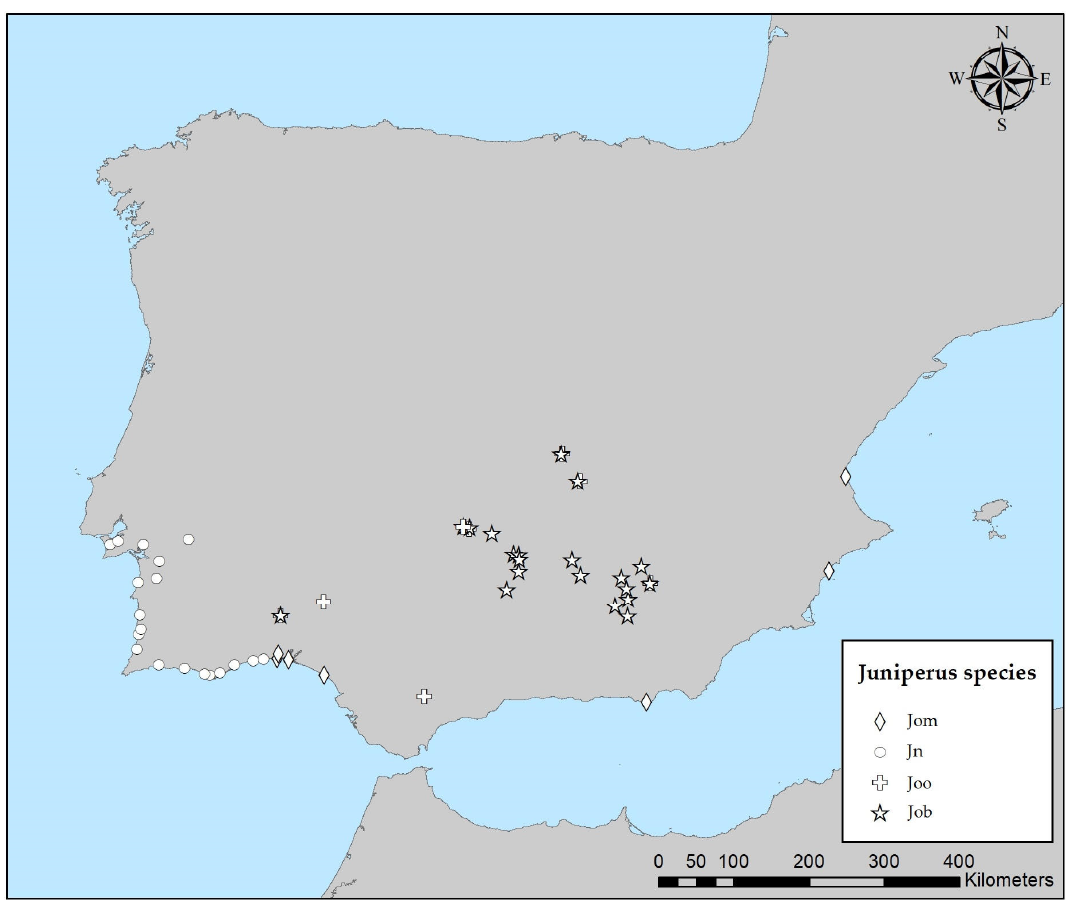
Figure 2. Distribution of Juniperus oxycedrus group in the study area of the Iberian Peninsula. Jom = J. oxycedrus subsp. macrocarpa , Jn = J. navicularis , Joo = J. oxycedrus subsp. oxycedrus , Job = J. oxycedrus subsp. badia .